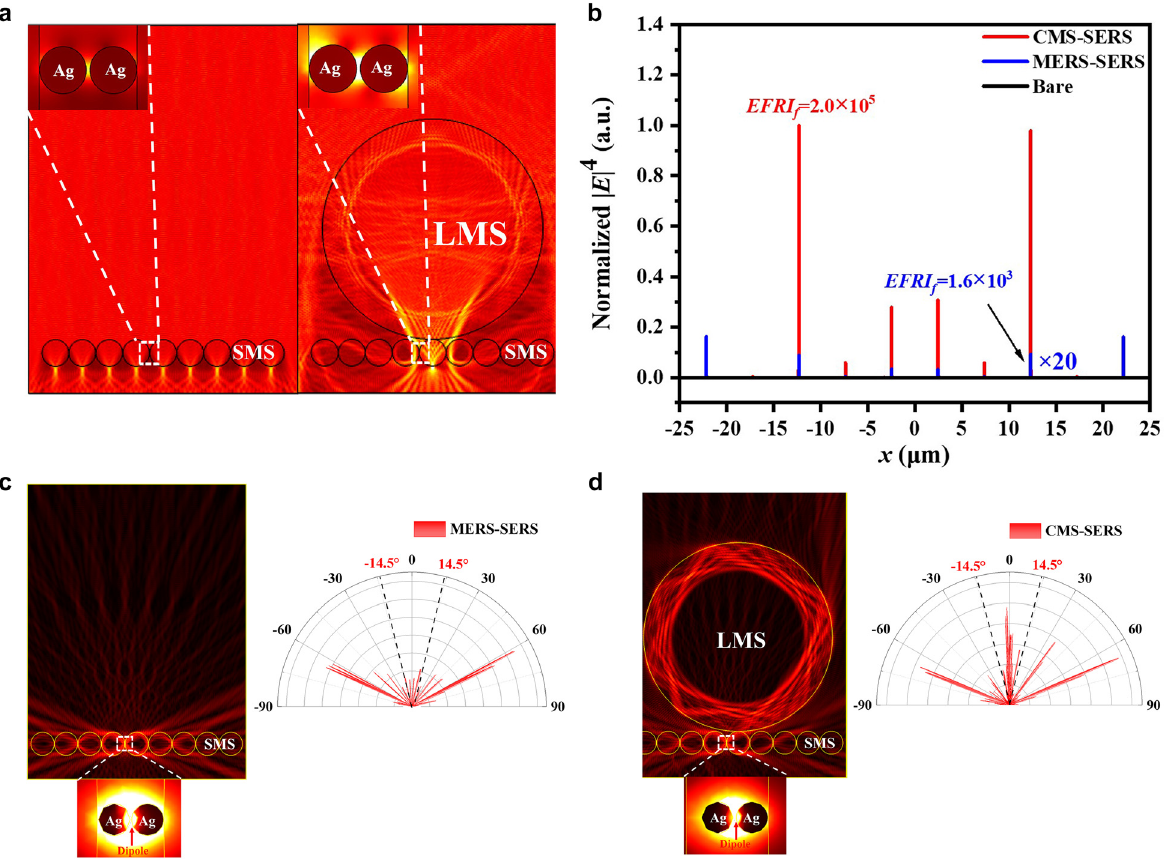
Figure 5: Numerical simulation of focusing property and directional antenna effect of CMS-SERS enhancers for Ag NP s located in the gaps between SMS. (a) Intensity distributions of electric fields in MERS-SERS and CMS-SERS configurations. (b) The corresponding EFRI f for Ag NP s located in the gaps between SMS. (c) and (d) Electric fi elds and far- fi eld emission patterns from (c) MERS-SERS and (d) CMS-SERS enhancers with the gap- attached Ag NP